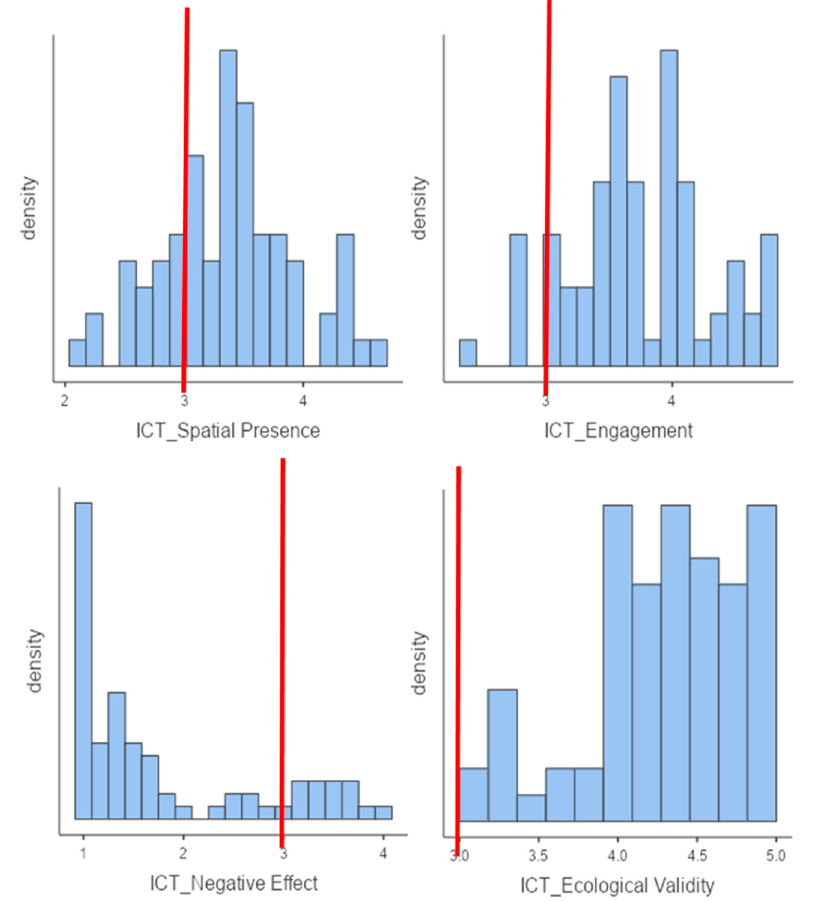
Figure 5. Graphic representation of five ICT-SOPI dimensions. The red lines indicate a neutral score.